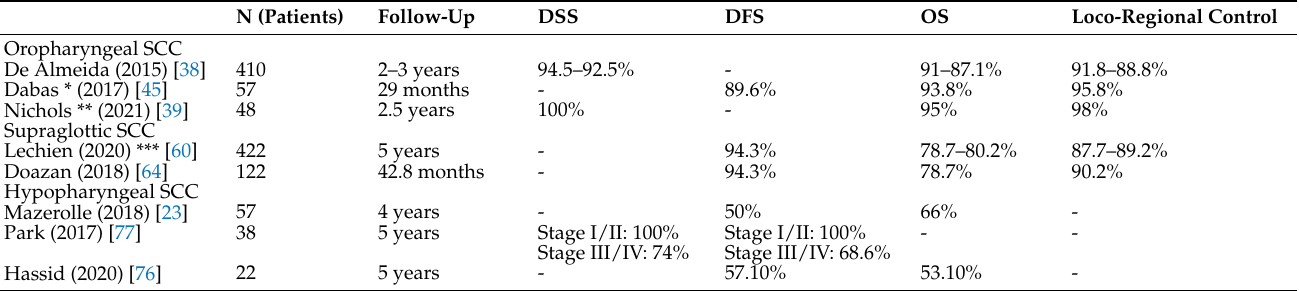
Table 1. Oncologic outcomes of transoral robotic surgery.